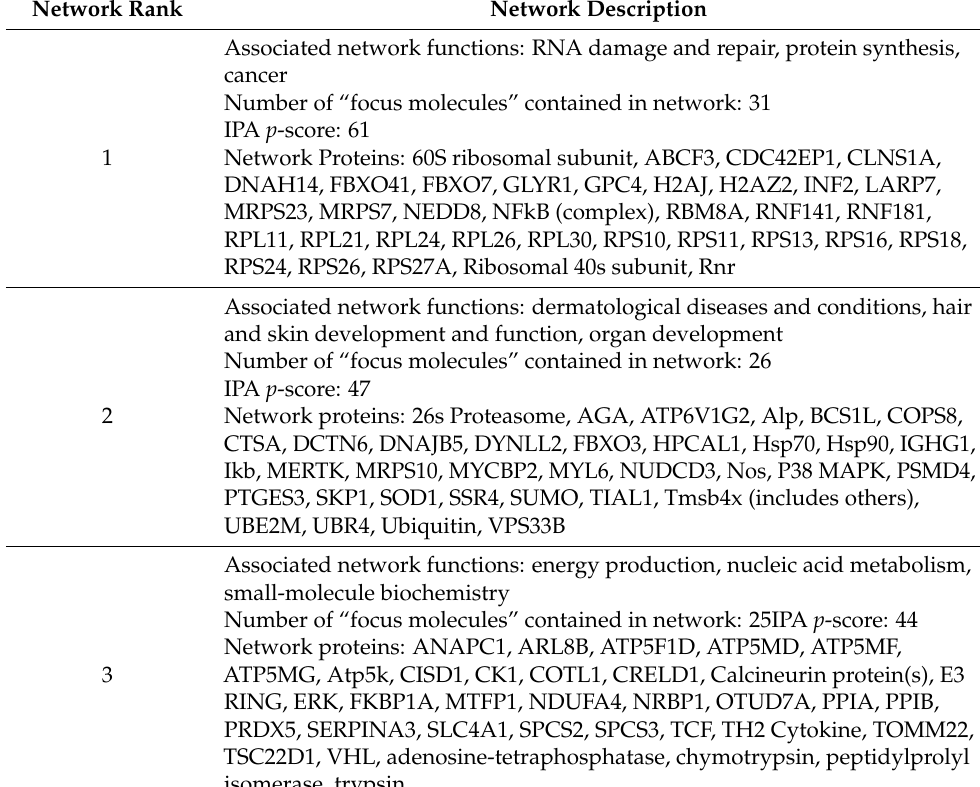
Table 3. Top 5 IPA protein networks associated with TAC treatment. Network